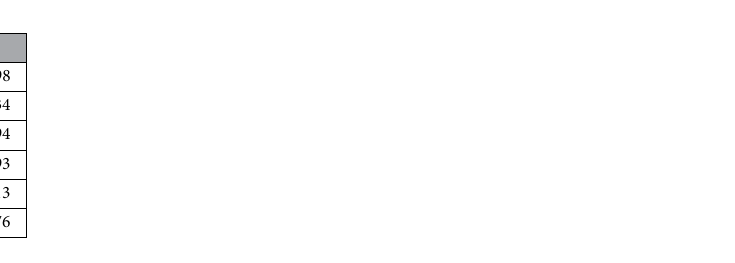
Table 2. Nusselt number variation against different parameters. Significant values are in